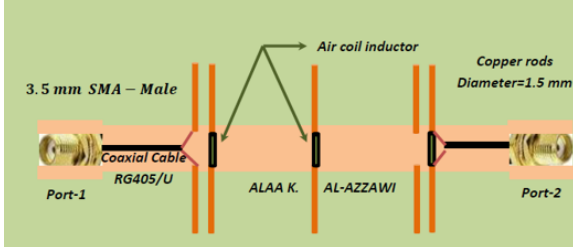
Fig. 9. Simulation sketch for parameter S 11 and the calcu- lated results of the ”3 r d − order ” dipole antenna filter.